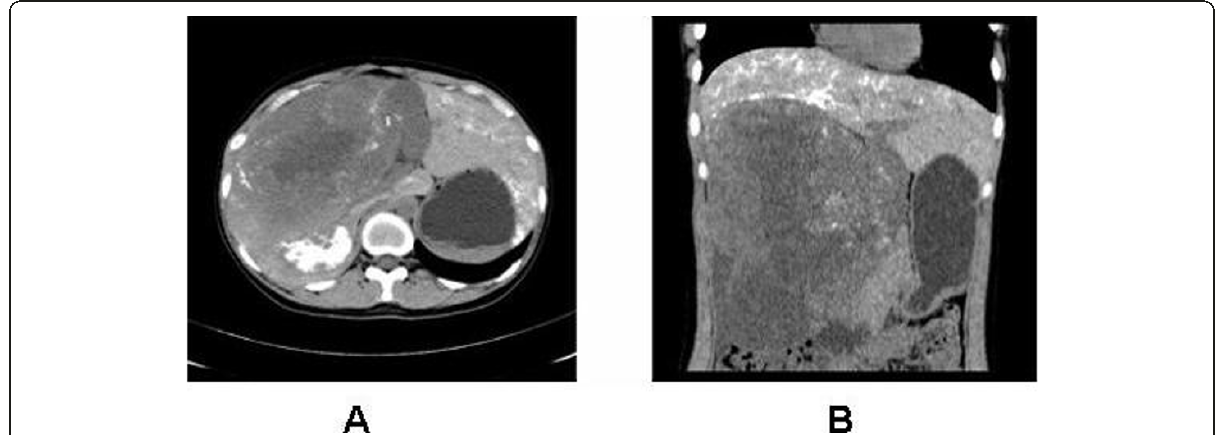
Figure 3 CT scan after the treatment of TACE shows that there is almost no lipiodol deposits in the tumor area